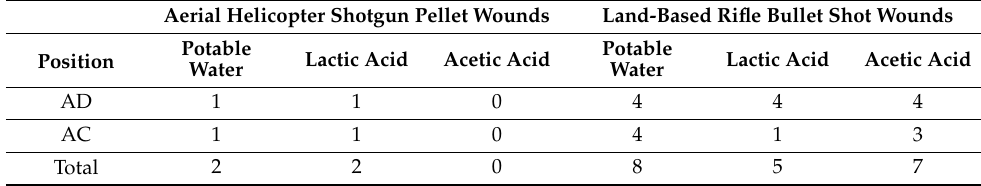
Table 2. Salmonella positive samples, position and